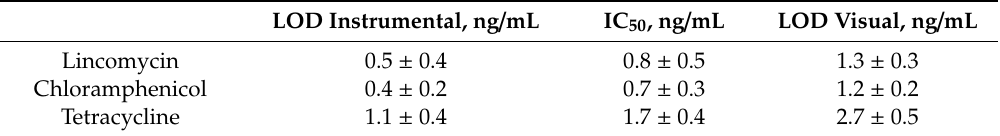
Figure 4. Appearance of the developed multiplex tests for three antibiotics. Test strips are arranged in accordance with the antibiotics concentrations in ng/mL. Table 1. Analytical parameters (n = 3) of the developed multiplex test for three antibiotics.